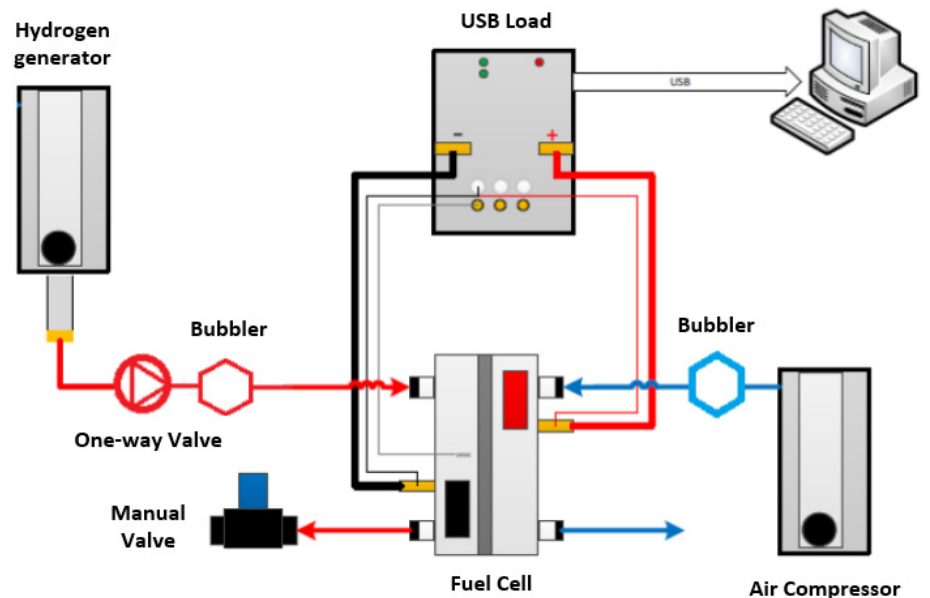
Figure 1. Layout and components of the experimental tests.